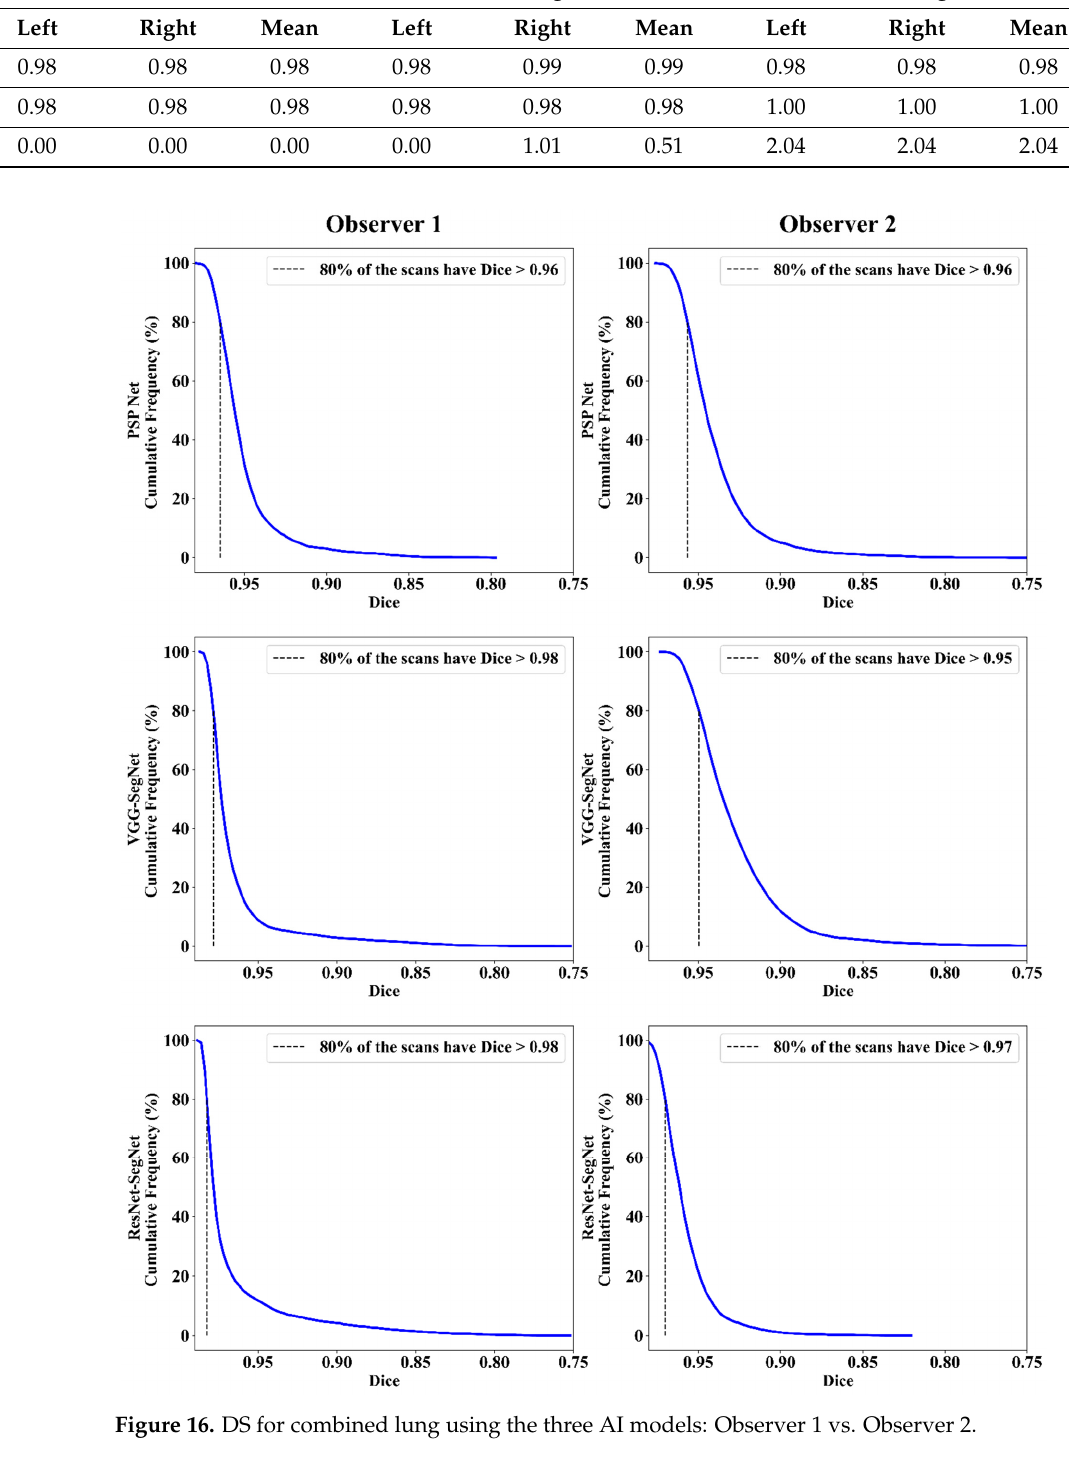
Table 1. Comparison of the CC values obtained between AI model area and the GT area corresponding to Observer 1 and Observer 2. PSP Net VGG-SegNet ResNet-SegNet